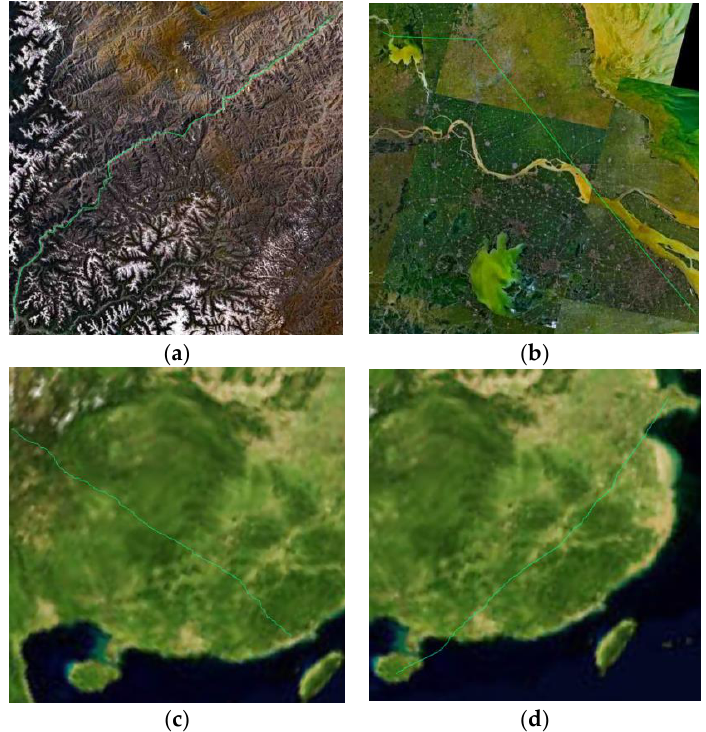
Figure 22. Planning results of 2–5 coordinate groups using MACO-pl. ( a ) Coordinate group 2 ; ( b ) Coordinate group 3 ; ( c ) Coordinate group 4 ; ( d ) Coordinate group 5 .